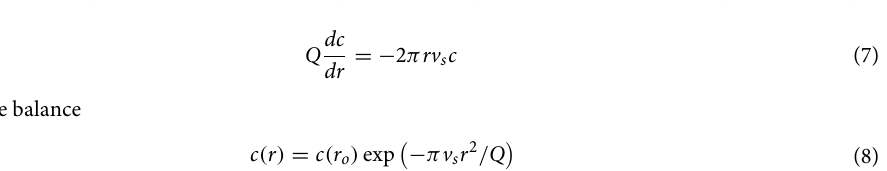
Figure 3. Experimental images illustrating how the fraction of fluid and particles rising from the top of the fountain varies with ( a ) the particle fall speed and ( c ) the density difference between the fountain fluid and the ambient fluid. All frames were taken 20 s after the initial injection. Experimental data showing the variation in the fraction of particles carried above the fountain as a function of ( b ) the dimensionless fall speed and ( d ) the buoyancy ratio of the interstitial fluid and particle